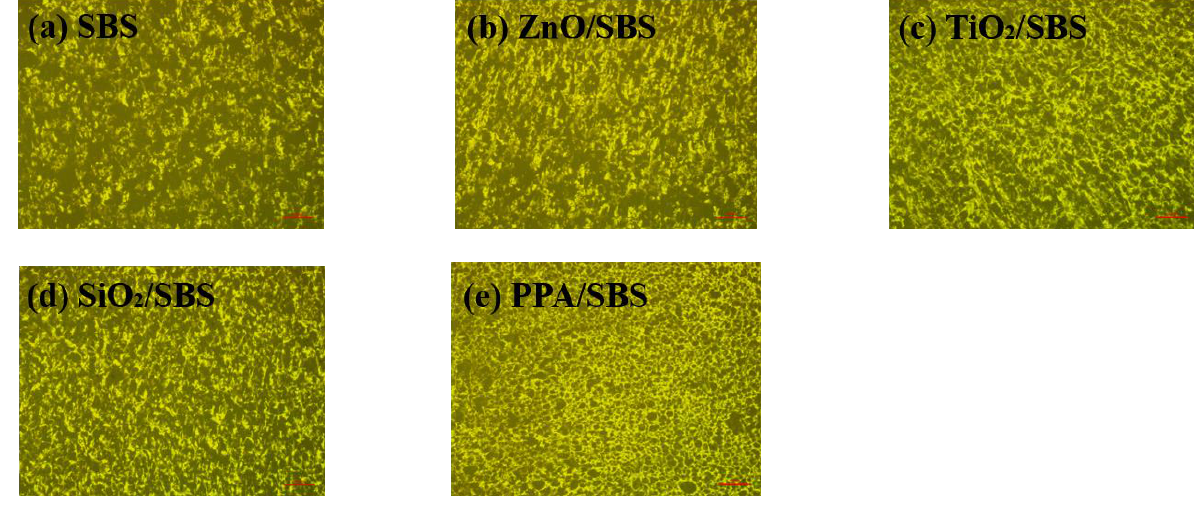
Figure 5. Fluorescence microscopy results of different polymer modified asphalts with a high content of linear